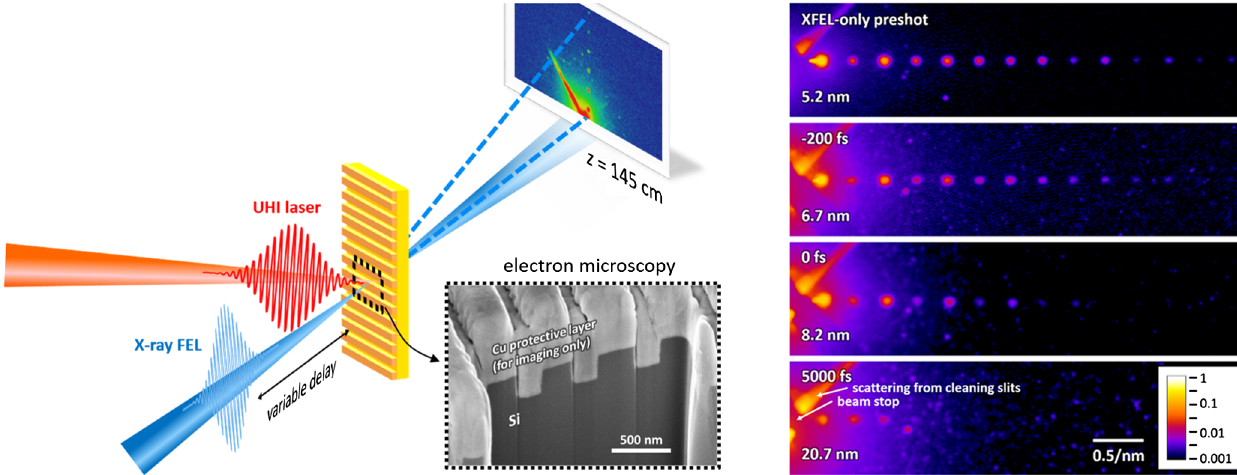
FIG. 1. Schematic of the SAXS experimental setup. Left: The HI laser pulse is focused on a silicon grating target under 45° parallel to the grating ridges and leading to a high-intensity laser-plasma interaction. The XFEL pulses probe the laser-plasma dynamics under 90°. The inset shows an electron scanning microscopy image of a representative target sample with grating period 500 nm (targets were covered with Cu only for imaging). Right: Examples of scattering patterns of a grating with period g ≅ 300 nm and ridge width b ≅ 150 nm for different XFEL delays (rotated by 90°, normalized to the respective intensity in the second scattering peak — the first one was sometimes